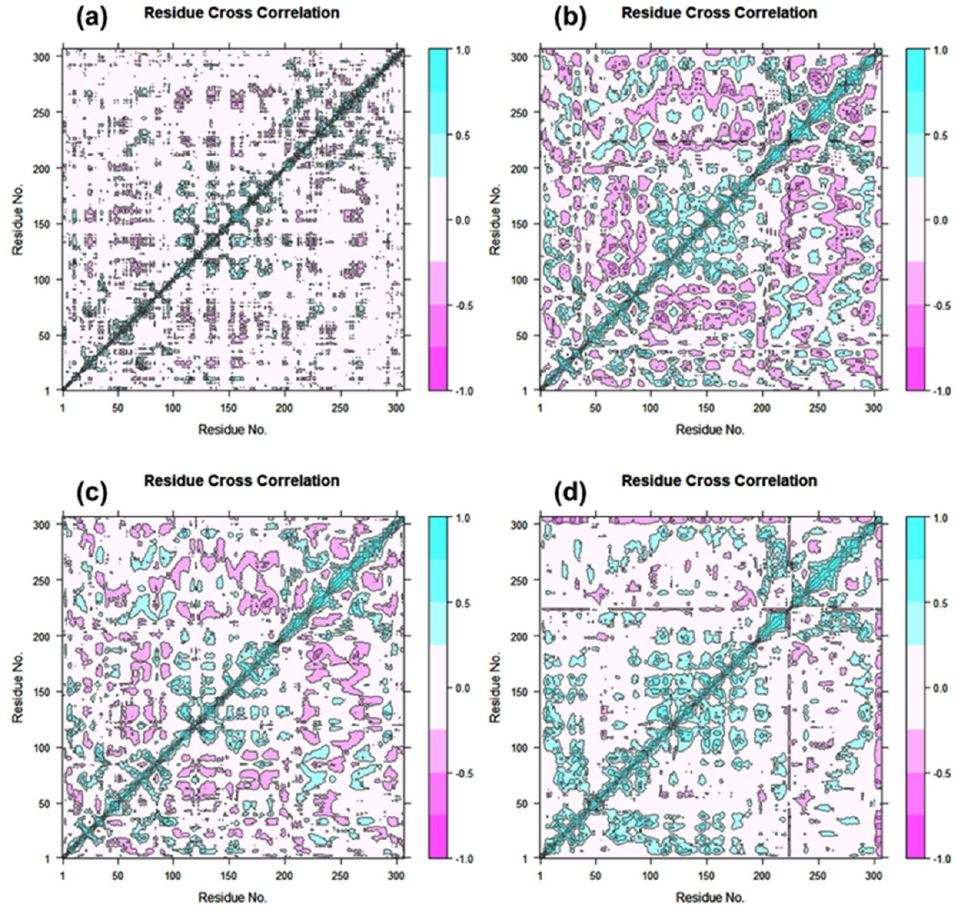
Figure 7 . Dynamic cross correlation for Tyrosinase complexed with ( a ) Cassameridine, ( b ) Laeta- nine, ( c ) Litseferine, and ( d ) Cassythicine, (Note Residues labels are numbered from 1–306 as in crystal structure). During a 100 ns simulation interval, the movement of residues exhibits a positive correlation in cyan colour and a negative correlation in cyan red.